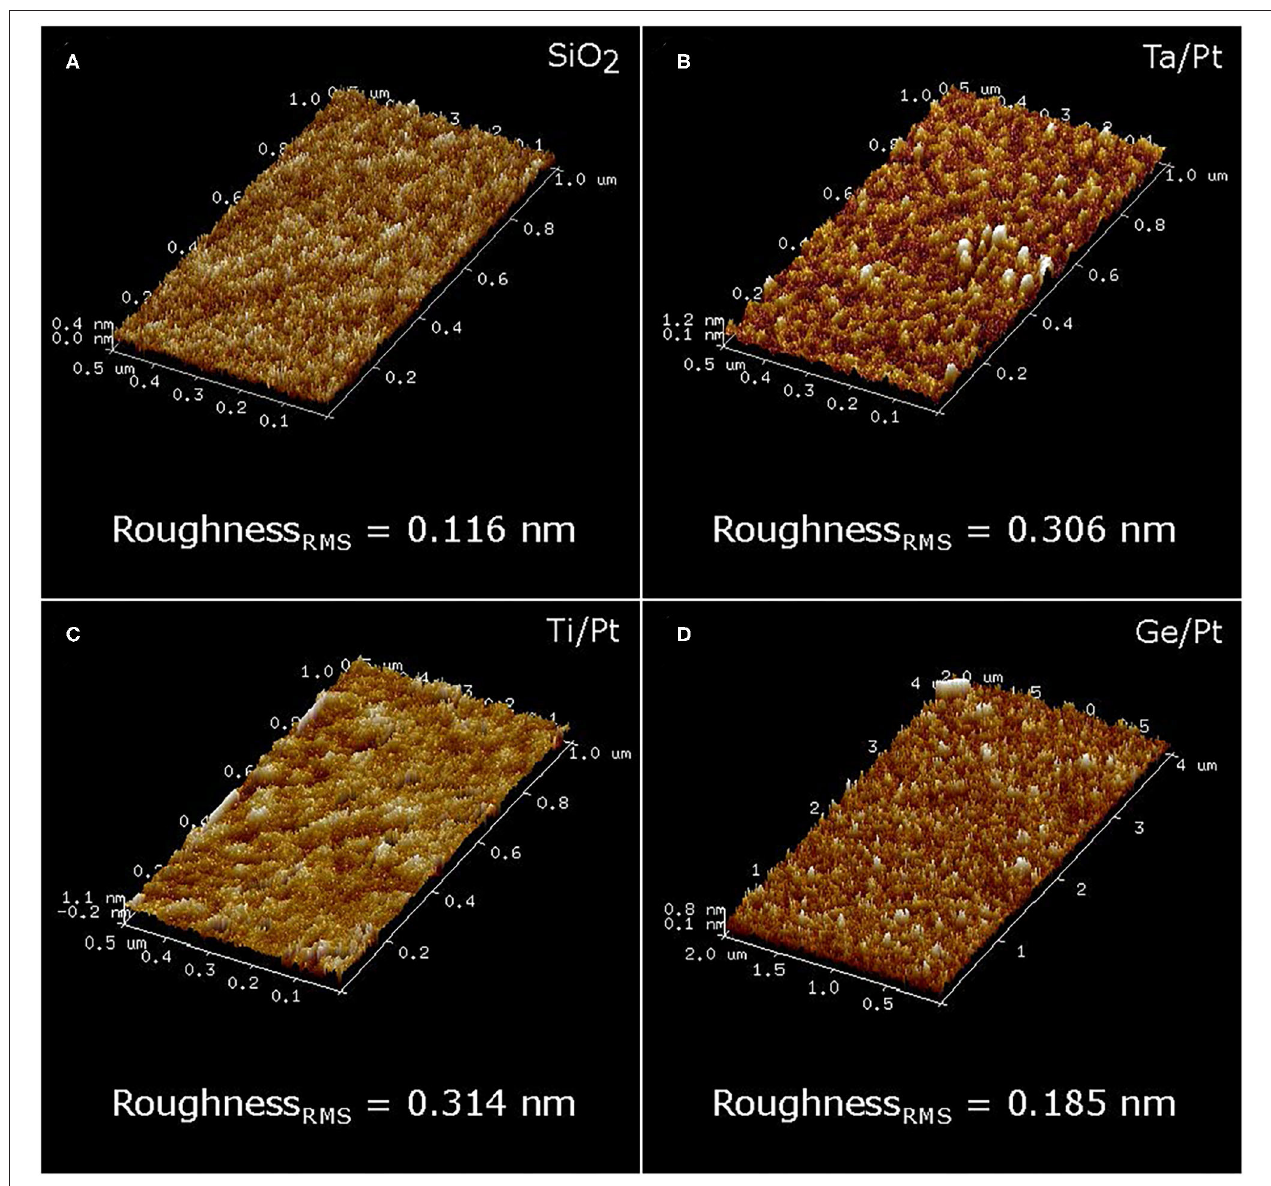
FIGURE 2 | Atomic force microscopy (AFM) topographic images of different surfaces. (A) SiO 2 (Substrate) surface. (B) Ta/Pt. (C) Ti/Pt. (D)